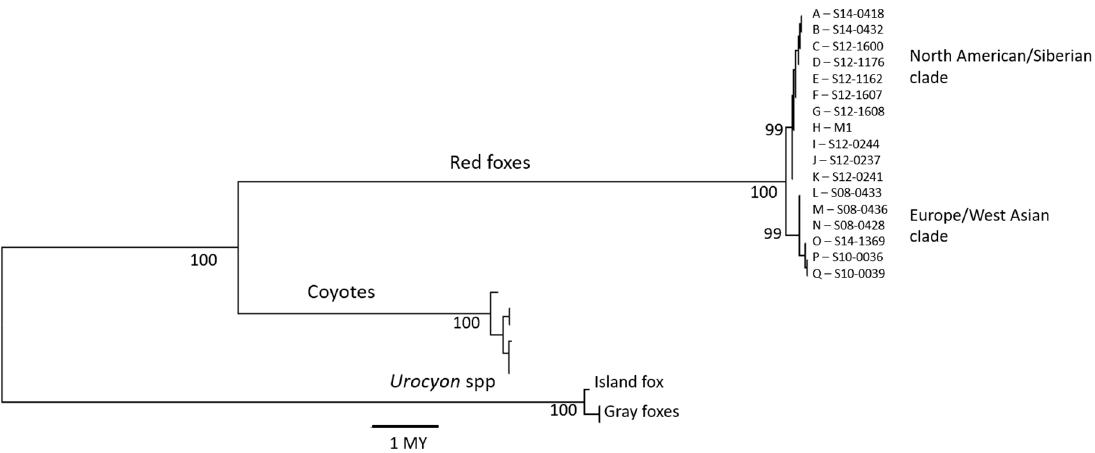
Figure 2. Coverage depths from sequencing reads of 19 red foxes mapped to 37,080 sites of 41 orthologous dog Y chromo- some fragments shown ( A ) with read depths arrayed across ordered sites on the reference fragments and ( B ) as a frequency distribution, illustrating a systematic pattern of coverage presumably corresponding to uniquely mapping Y chromosome sites (10–160 ×), sites likely to reflect two paralogs (including one on the X chromosome, 161-210 ×) and sites with > 2 paralogs (> 210 ×). Only sites with depths ranging from 10 to 160 × were used in analyses. Sites with depths of < 10 × were presumed to reflect errors and those > 160 × were presumed to reflect paralogs, not necessarily all on the Y chromosome.